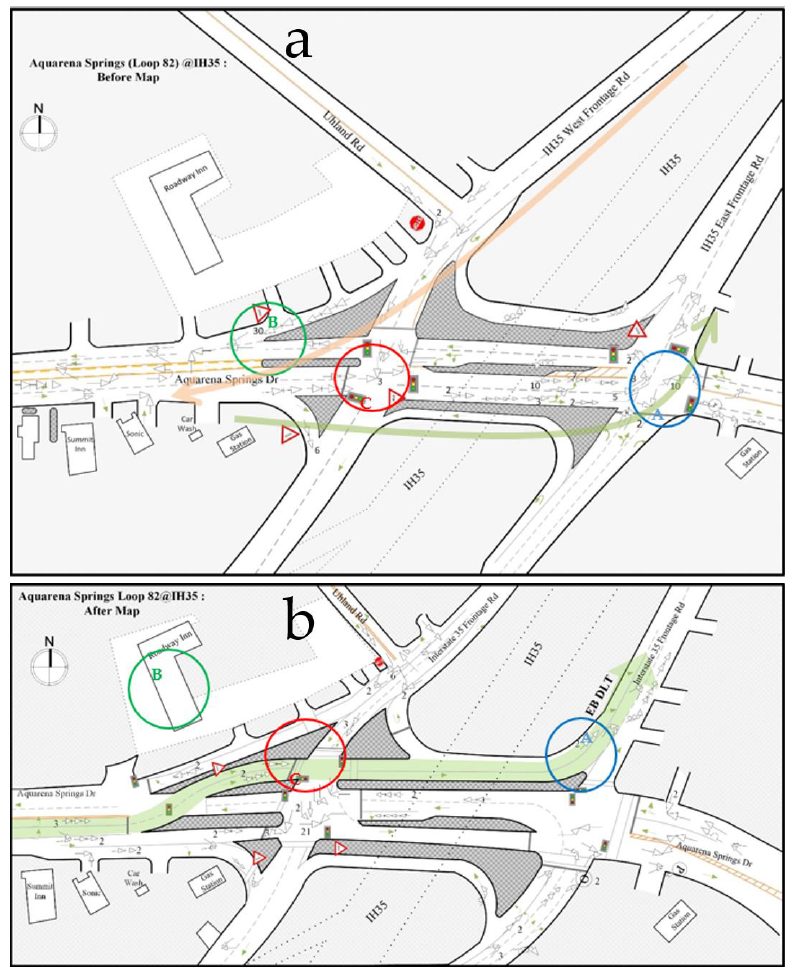
Figure 2. Collision diagrams at Intersection 1 (Loop 82, Aquarena Springs Drive at IH 35). ( a ) Collision diagrams before the implementation of DLT. ( b ) Collision diagrams after the implementation of DLT.